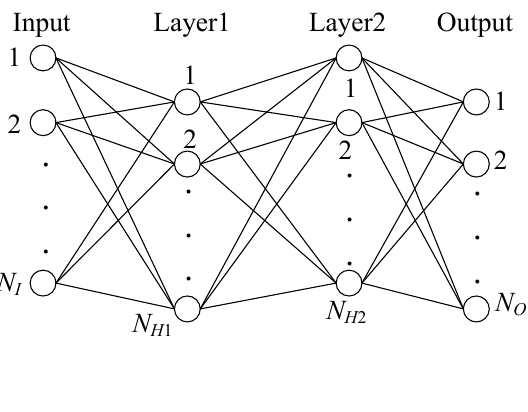
Figure 2. A three-layer neural network.